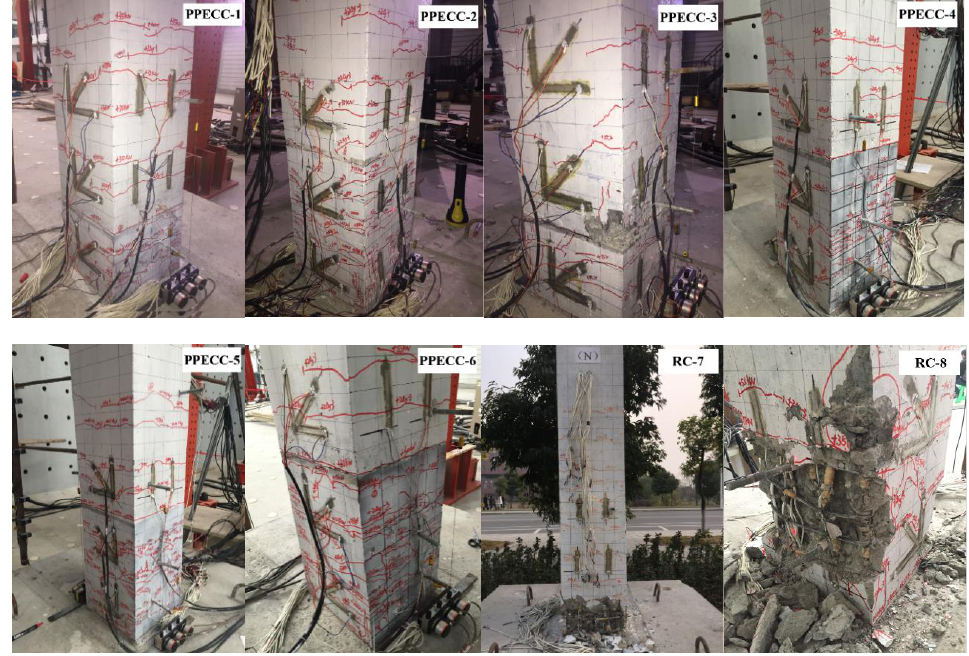
Figure 7. Crack patterns and failure modes of specimens.